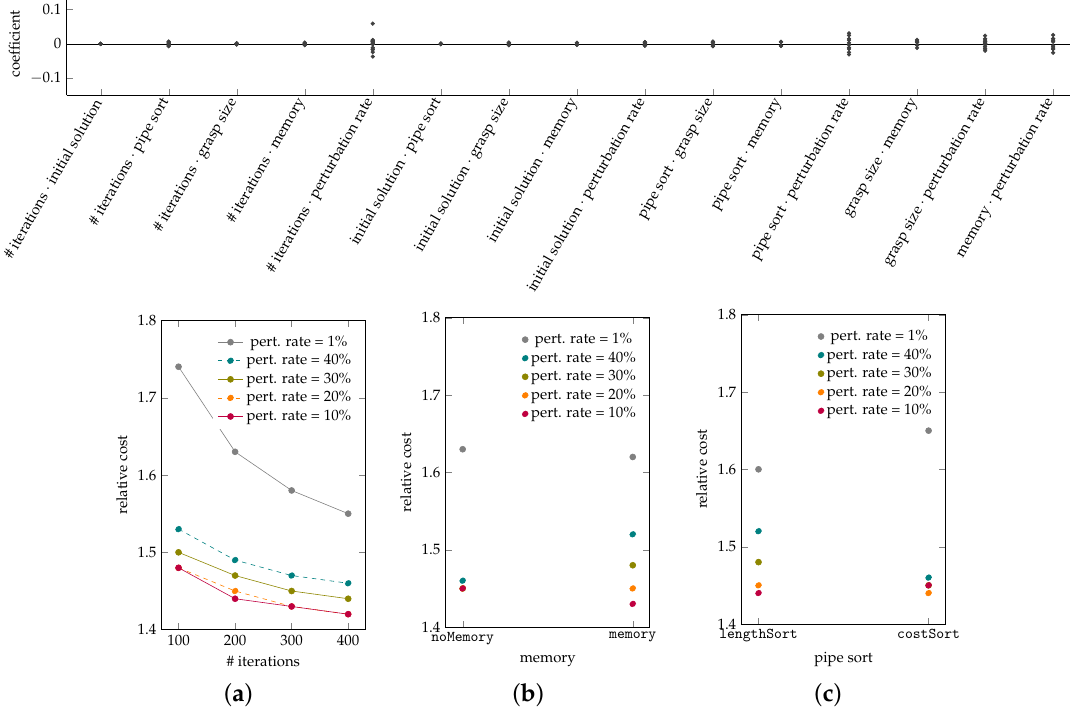
Figure 9. Values of the coefficients and mean plots for the regression model on the relative cost : main and interaction